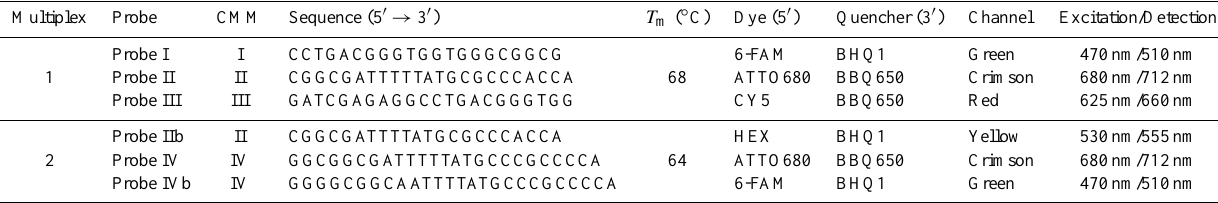
Figure 2. Alignment of CMM sequences produced in this study to reference CMMs (Schroeder et al., 2005). The CMM region is boxed. The dash line indicates the split between two subgroups of CMMs based on variation outside the CMM genotype. The bases shaded in grey show the positions of the probes (Table 3). Table 3. Emiliania huxleyi dual-labelled probes for the CMM probe assay.